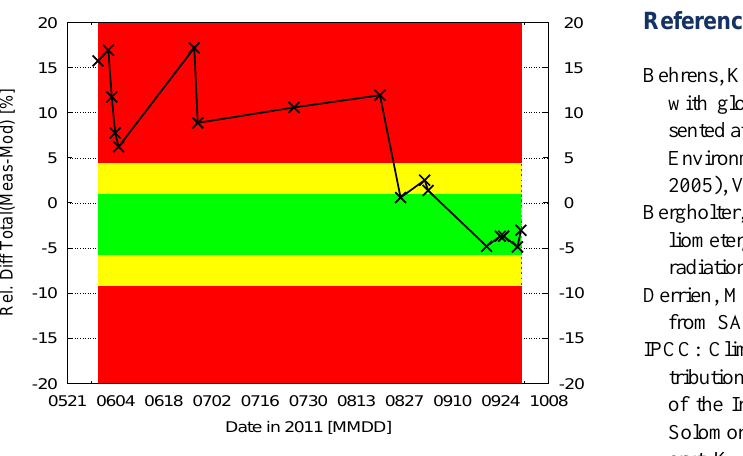
Figure 8. Relative Di ff erence of measured and calculated short- wave radiation at Magdeburg / Saxony-Anhalt. Green area indicates ± 1 σ , yellow ± 2 σ